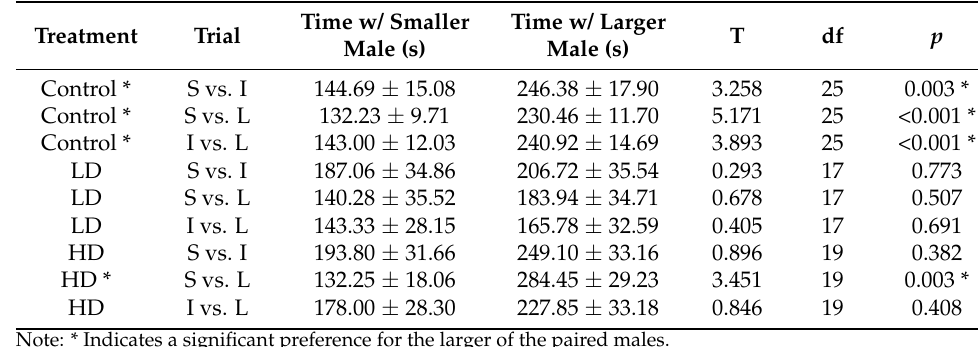
Table 1. Results of paired sample t -tests comparing the mean time spent in association with the larger- versus smaller-male dummy for the LD, HD, and control groups of expt. III. ‘S’, ‘I’, and ‘L’ refer to the small, intermediate, and large male dummy stimuli, respectively.